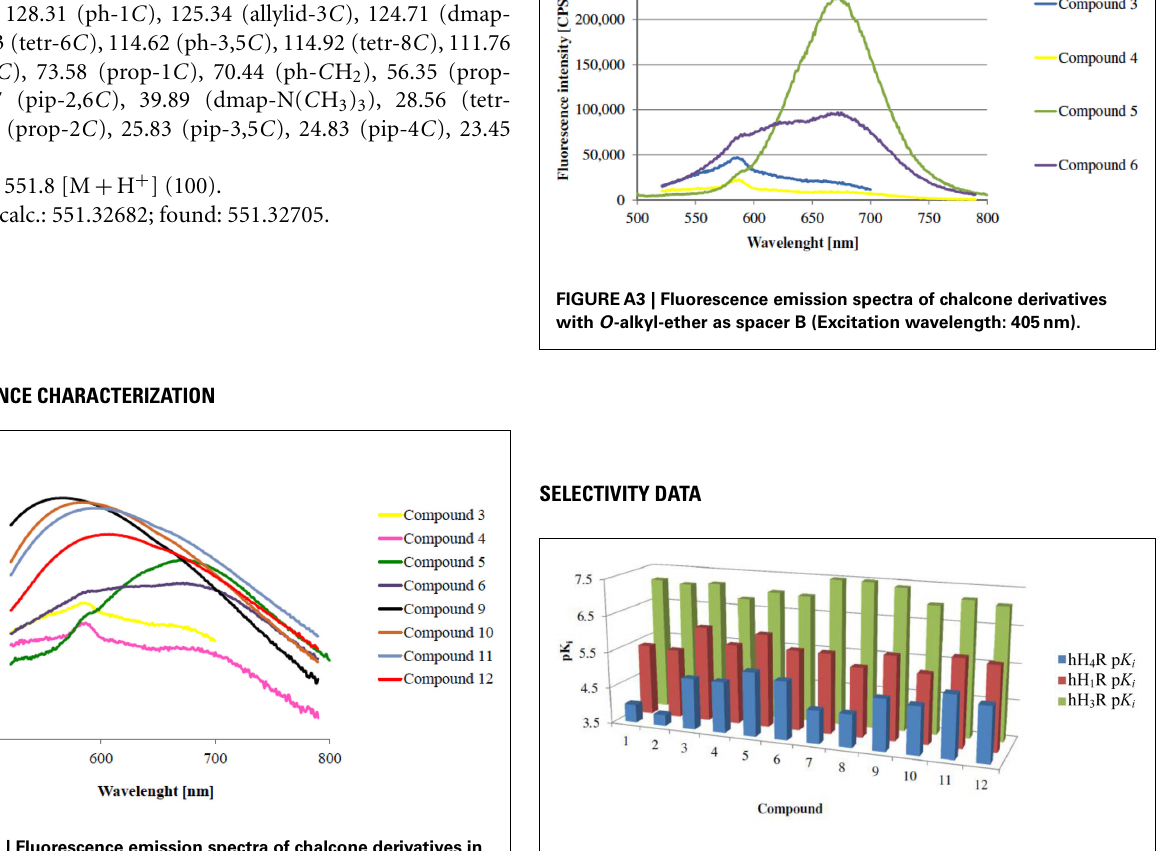
FIGUREA4 | Graphic chart of human histamine H 1 , H 3 , and H 4 receptor p K i